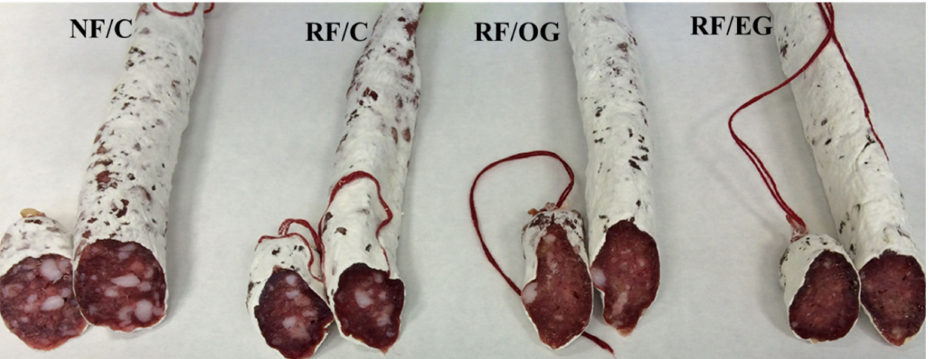
Figure 3. E ff ect of formulation strategies on the external and cross-sectional appearance of the fuets after the ripening process. For sample denominations see Table